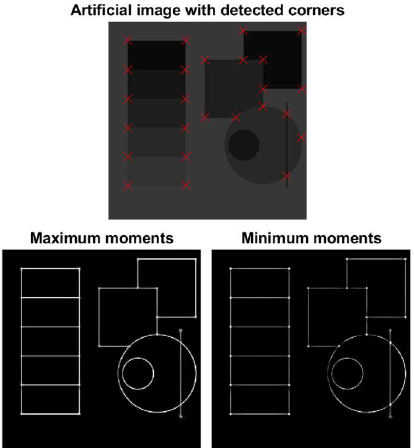
Figure 2. Maximum and minimum momments of an artificial image with low